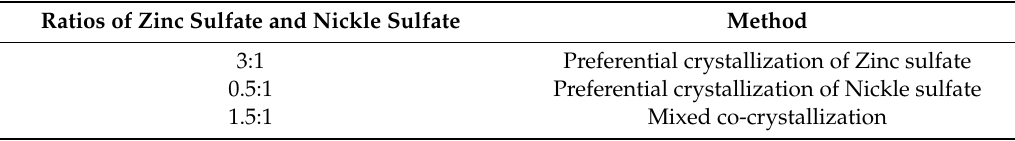
Table 2. Three di ff erent methods to treat mixed solutions.